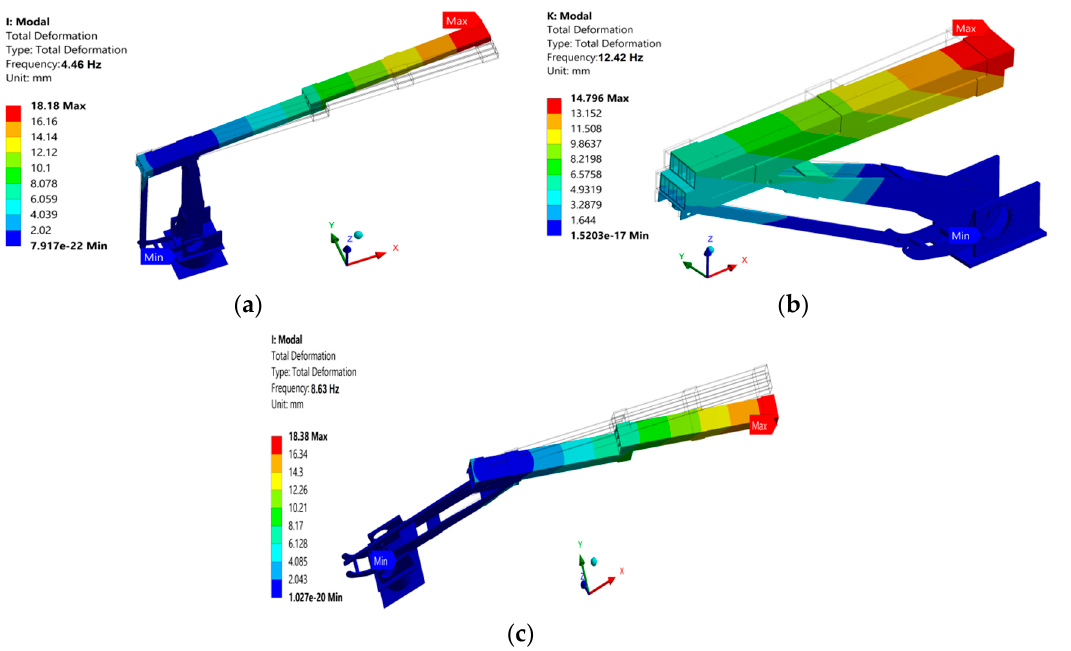
Figure 10. First mode shapes of the AA manipulator: ( a ) first configuration, ( b ) second configuration, and ( c ) third configuration.